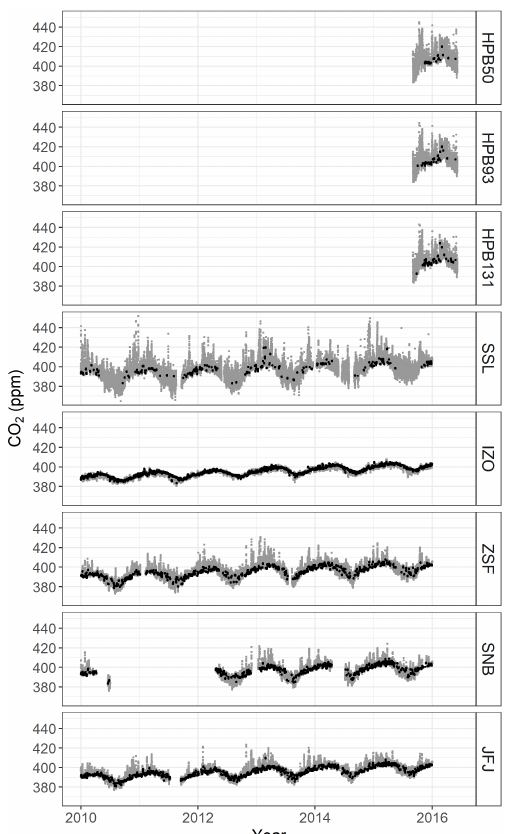
Figure 3. Time series plots of validated CO 2 datasets (gray), and selected datasets by ADVS (black) at six GAW